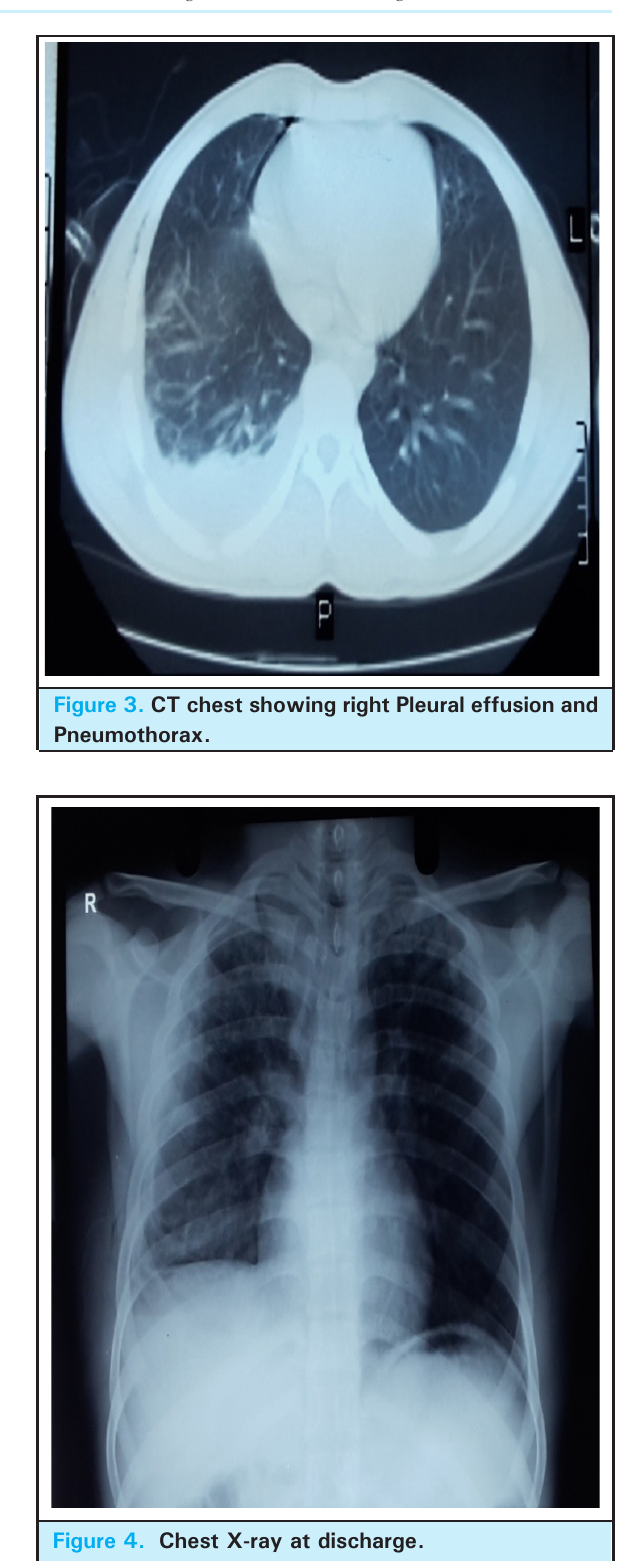
Figure 4. Chest X-ray at discharge.